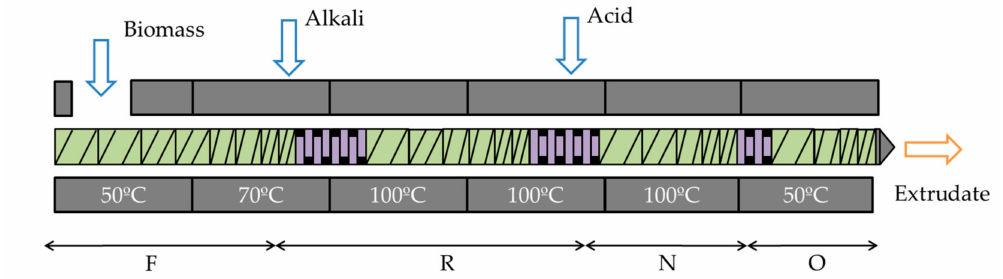
Figure 1. Functional zones, screw profile, temperature profile and material inputs and outputs used for the extrusion of olive stone. Green—transport screws; Purple—mixing screws. F: feeding zone; R: reaction zone; N: neutralization zone; O: output